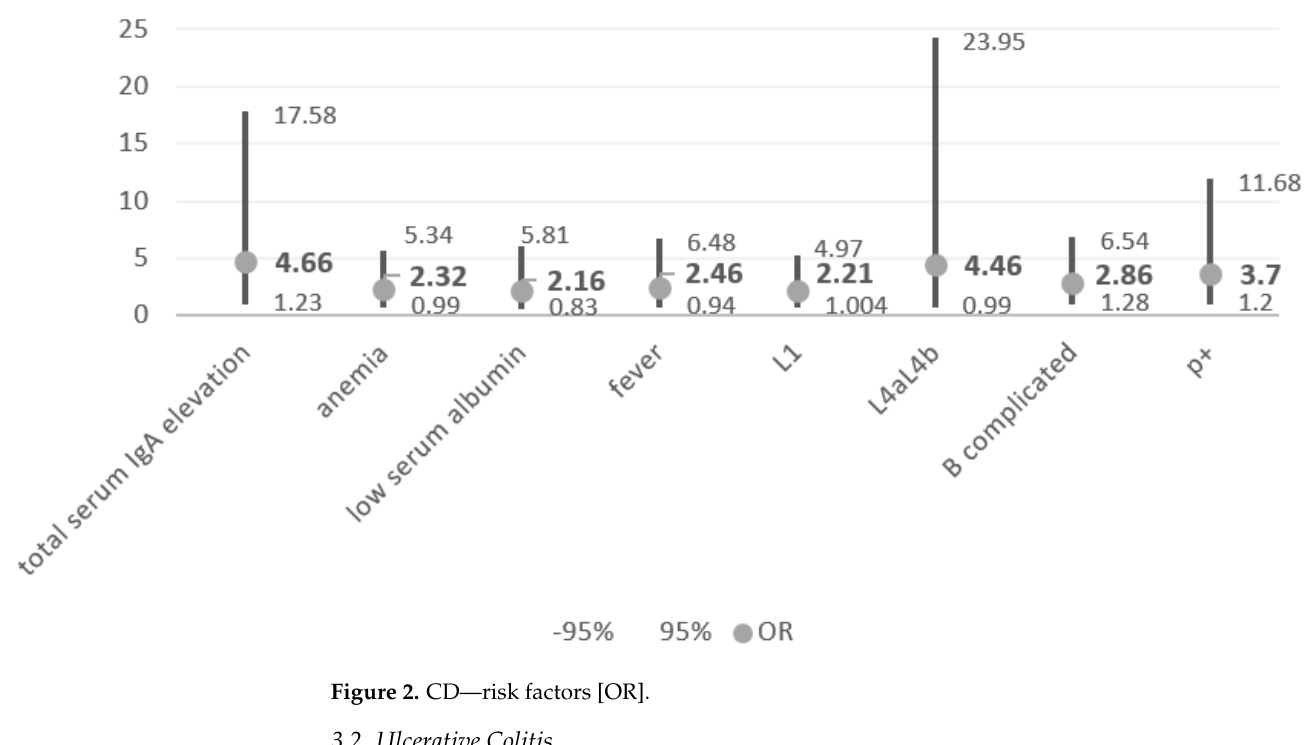
Figure 2. CD — risk factors [OR]. Figure 2. CD—risk factors [OR].